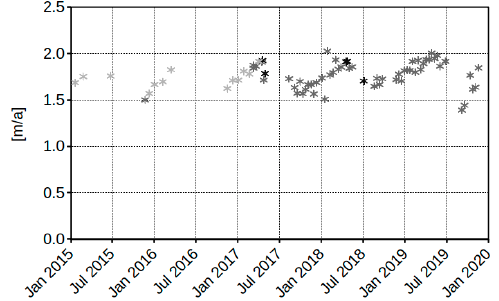
Figure 11. Velocity along the maximum slope direction at the front of Dos Lenguas rock glacier (Argentinian Andes) from Sentinel-1 InSAR. Light grey indicates 24 days, grey indicates 12 days, and black indicates 6 day time intervals. For position see black circle in Figure 10a.